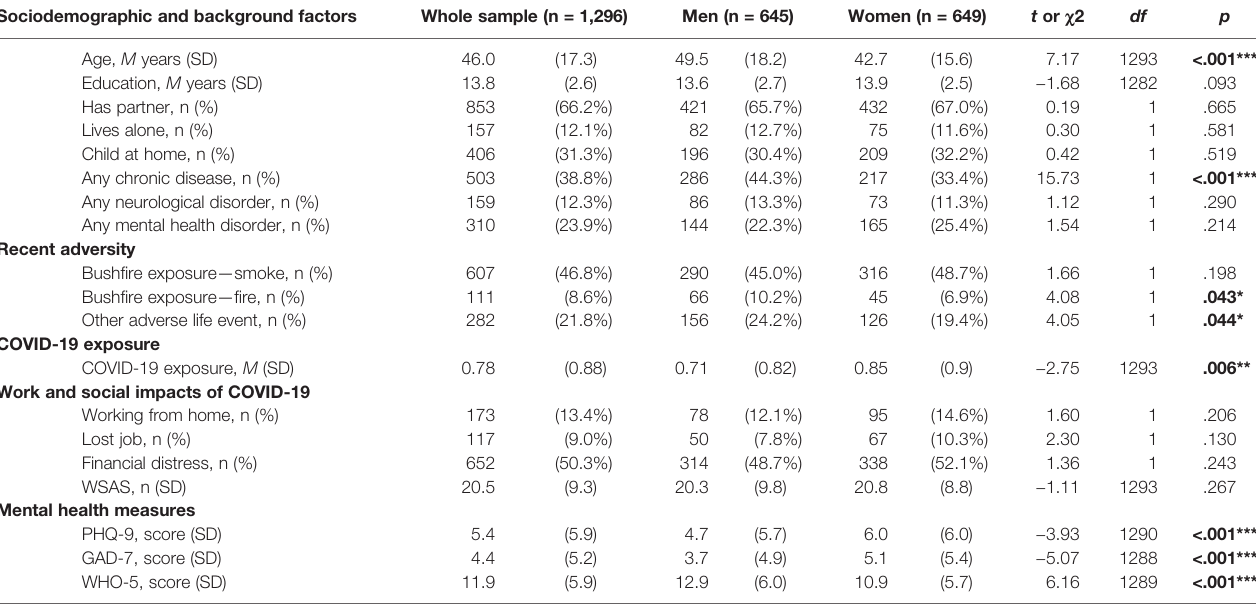
TABLE 2 | Description of sample characteristics, including comparison of men and women. Sociodemographic and background factors